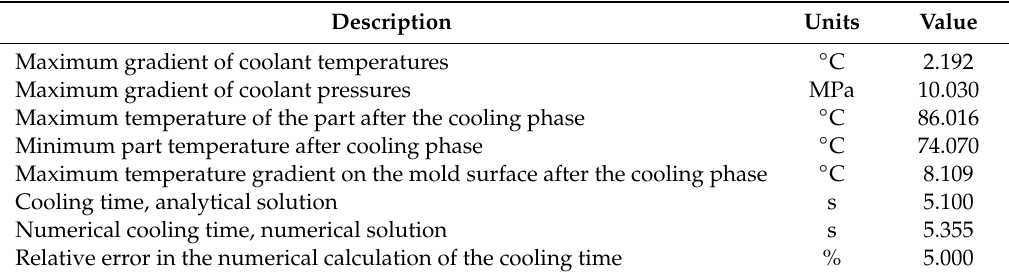
Table 10. Numerical results obtained for Case B cooling analysis.